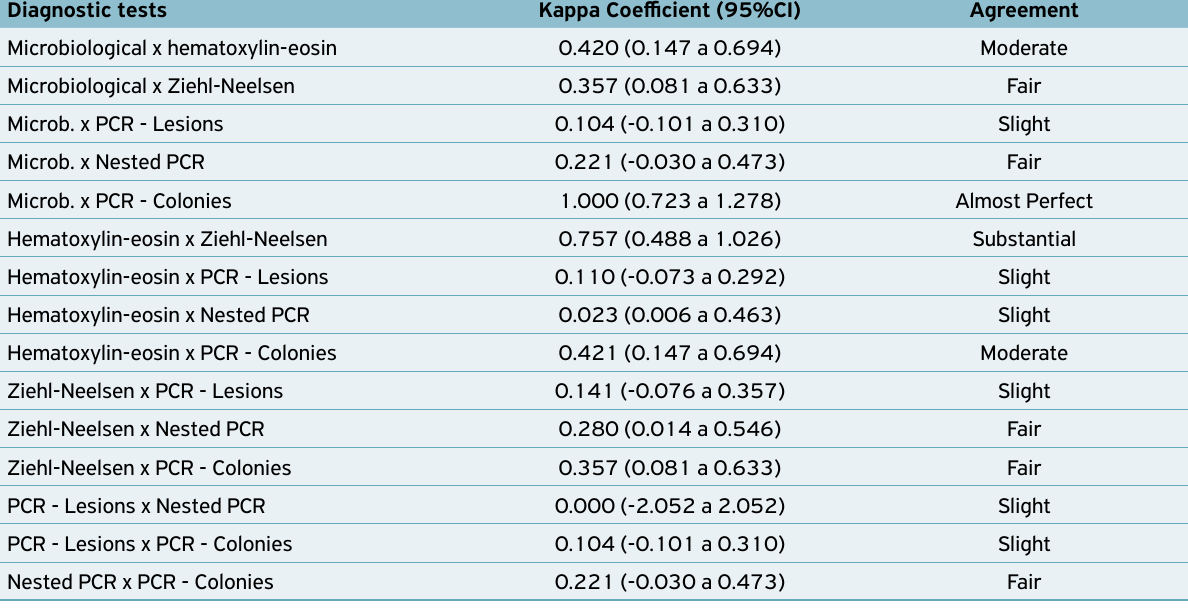
Table 3. Agreement between diagnostic tests expressed by the Kappa coefficient.